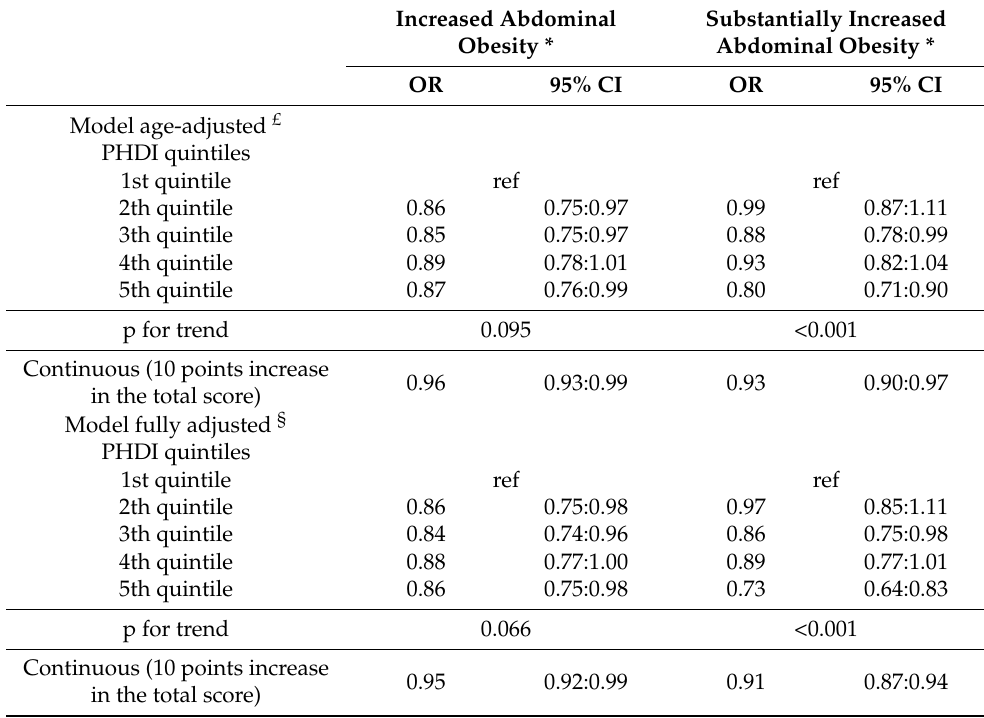
Table 4. Multiple multinomial logistic regression between Planetary Health Diet Index and over- weight and obesity. ELSA-Brasil,